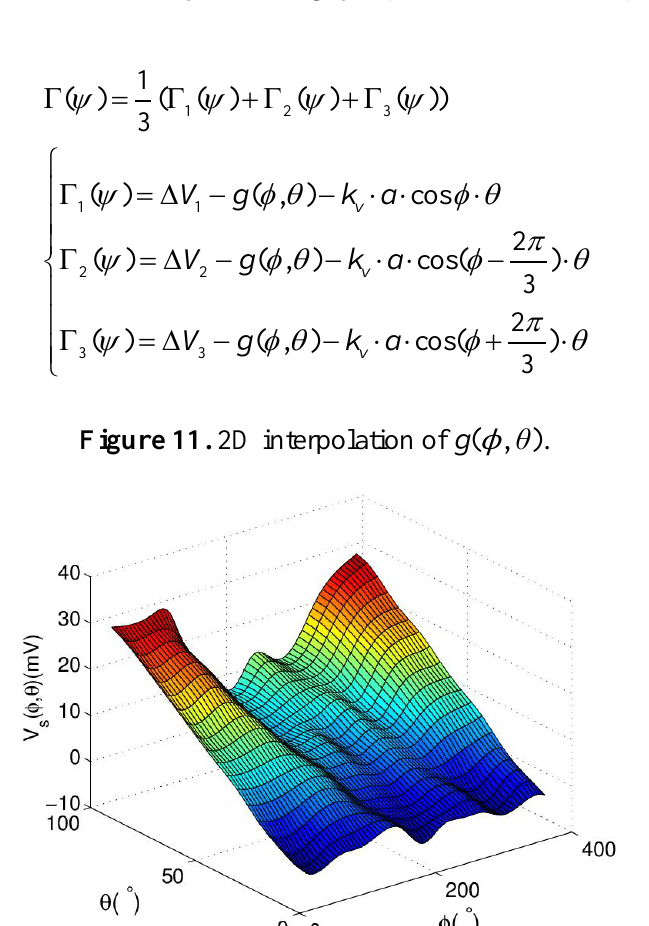
Figure 11. Substituting the estimated ϕ , θ and g ( ϕ , θ) into Equation (8), Γ( ψ ) can be obtained